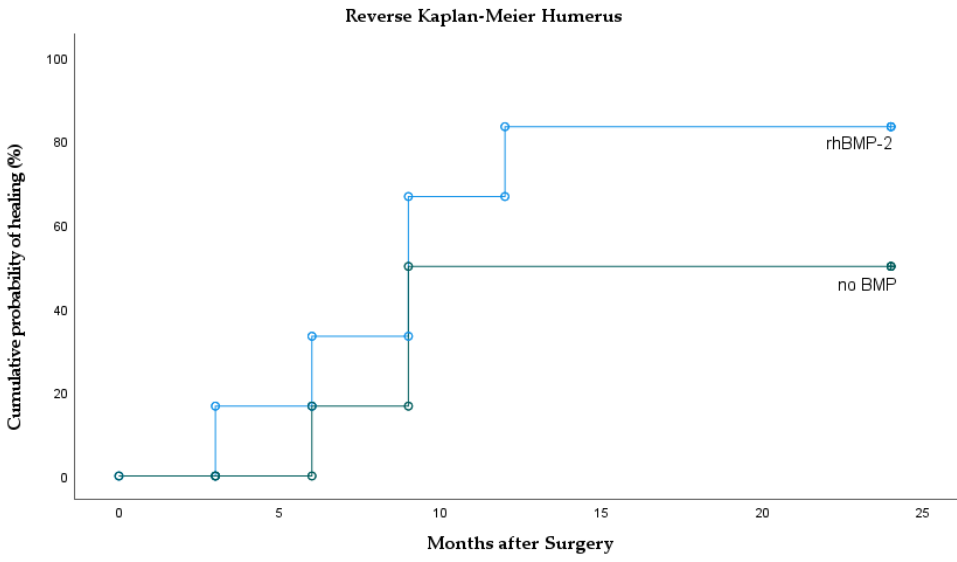
Figure 3. Reverse Kaplan–Meier curves of the humerus showing the incidence of bone healing with and without rhBMP-2 application.